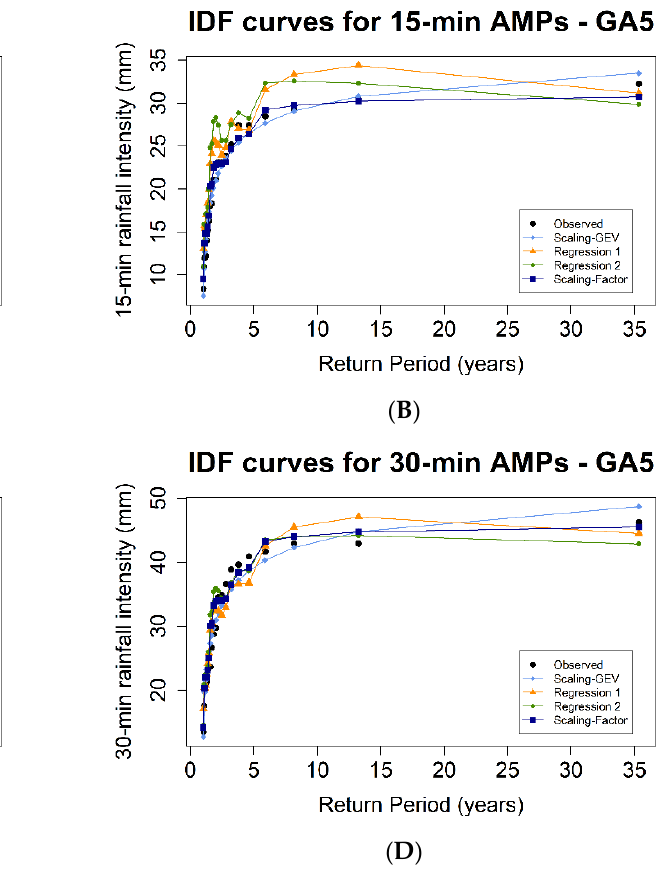
Figure 5. Test of Simple scaling. ( A ) is a plot the scaling exponent against order of NCM of AMPs for Almagosa, ( B ) for Fena Lake, ( C ) for Geomag, ( D ) Mt. Chachao, ( E ) for Mt. Santa Rosa, ( F ) for Umatac, and (G) for Windward Hills, respectively.